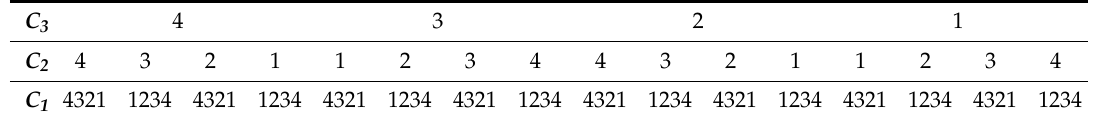
Figure 4 . Code-space diagram.